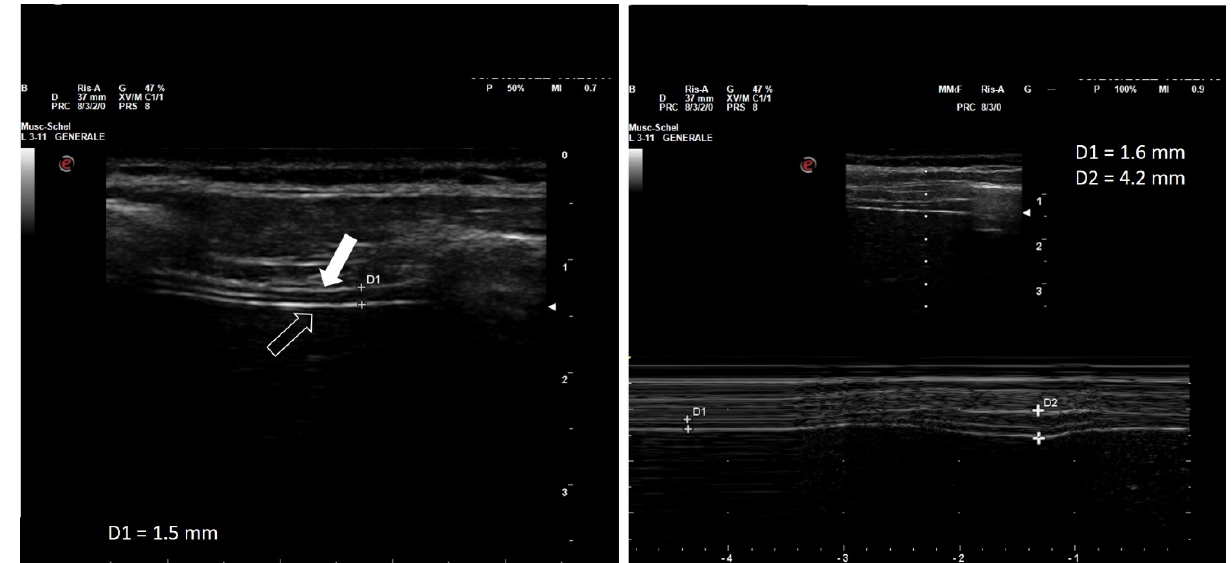
Figure 1. Thickness of the right hemi-diaphragm at the zone of opposition ( left panel) and diaphragm thickening during maximal inspiration ( right panel) in a healthy woman in her thirties while semi-recumbent. Left panel: note the two hyperechoic lines (arrows) representing the peritoneum (empty arrow) and parietal pleura (filled arrow). The measured thickness (D1) is 1.5 mm. Right panel: the same diaphragmatic region during maximal inspiration from resting volume to total lung capacity. Diaphragmatic thickening is examined in motion mode (M-Mode). During full inspiration, thickness increases from 1.6 (D1) to 4.2 mm (D2), equal to a thickening fraction of 162%. Own image.